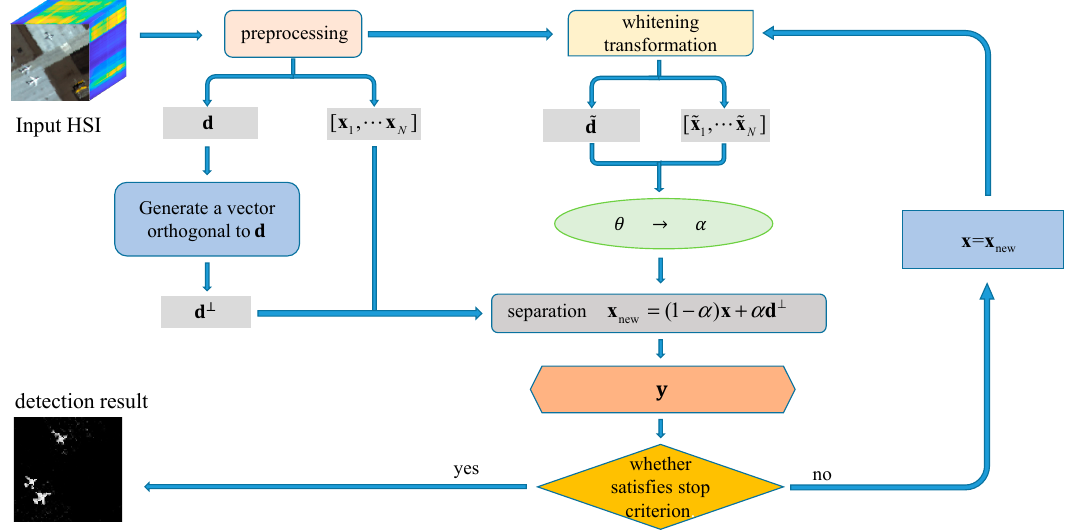
Figure 8. Flowchart of the proposed angle distance-based hierarchical background separation (ADHBS) algorithm.